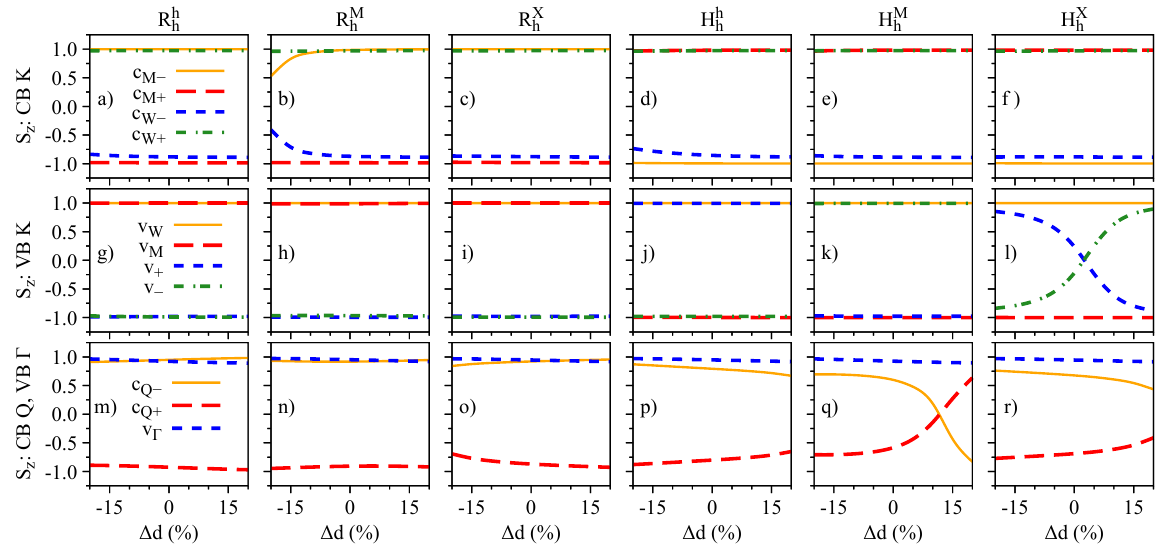
Figure 8. Same as Figure 4 but as a function of the interlayer distance